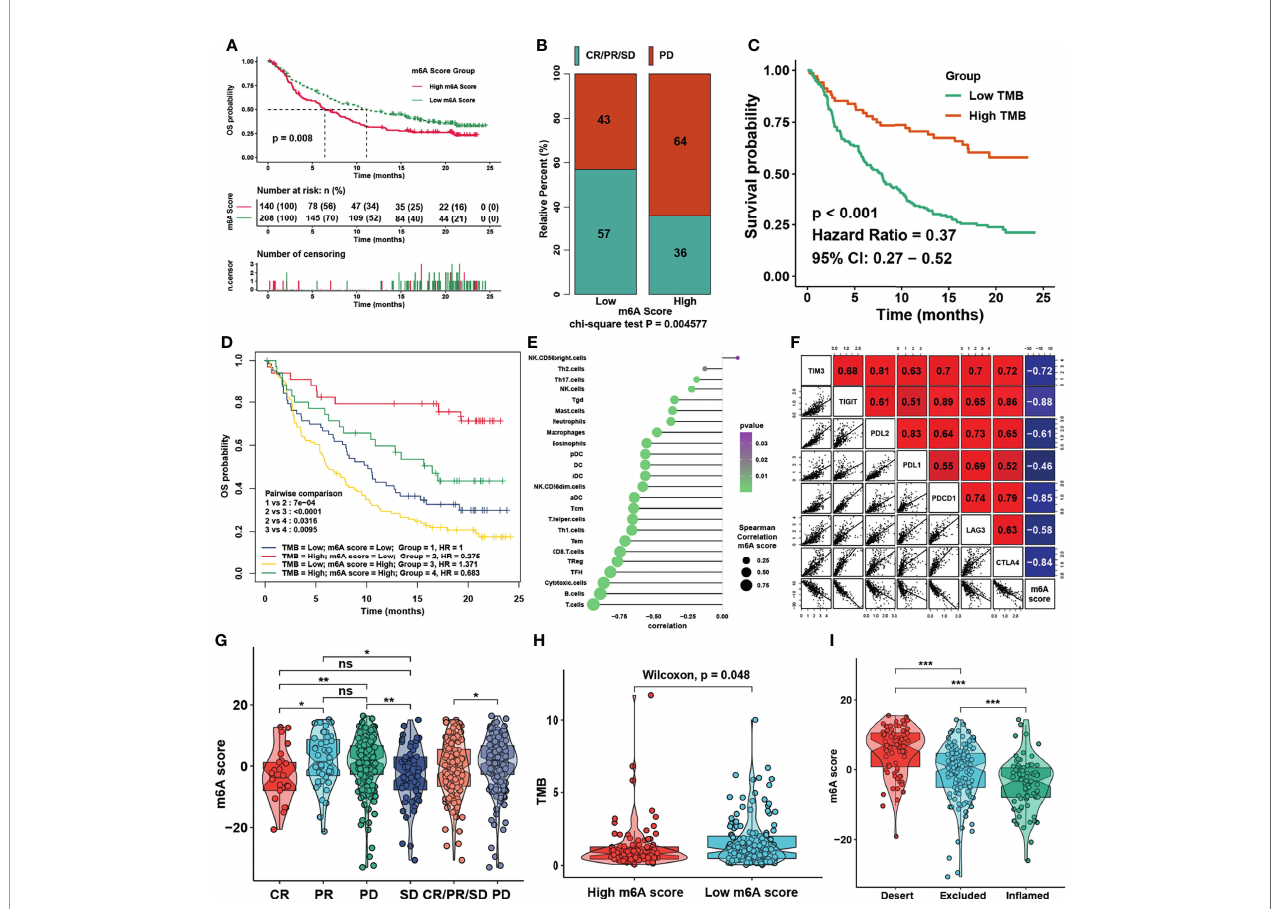
FIGURE 9 | m6A modi fi cation patterns in the role in immunotherapy. (A) Survival analysis for m6A score in IMvigor210 cohort. (B) Rate of clinical response to anti-PD-L1 immunotherapy in high or low m6A score groups in the IMvigor210 cohort using chi-square test. (C) Survival analysis for TMB in the IMvigor210 cohort. (D) Survival analyses for patients treated with anti-PD-L1 immunotherapy strati fi ed by both m6A score and tumor mutation burden (TMB) using Kaplan – Meier curves. (E) Correlations between m6Ascore and TME in fi ltration in NPC using Spearman analysis. (F) Correlations between m6Ascore and immune checkpoint inhibitors in NPC using Spearman analysis. (G) Distribution of m6A score in distinct anti-PD-L1 clinical response groups. (H) Distribution of TMB in different m6A score groups. (I) Differences in m6A score among distinct tumor immune phenotypes in IMvigor210 cohort. The asterisks represented the statistical p-values in panels (F, H) (*P < 0.05; **P < 0.01; ***P < 0.001); ns, no signi fi